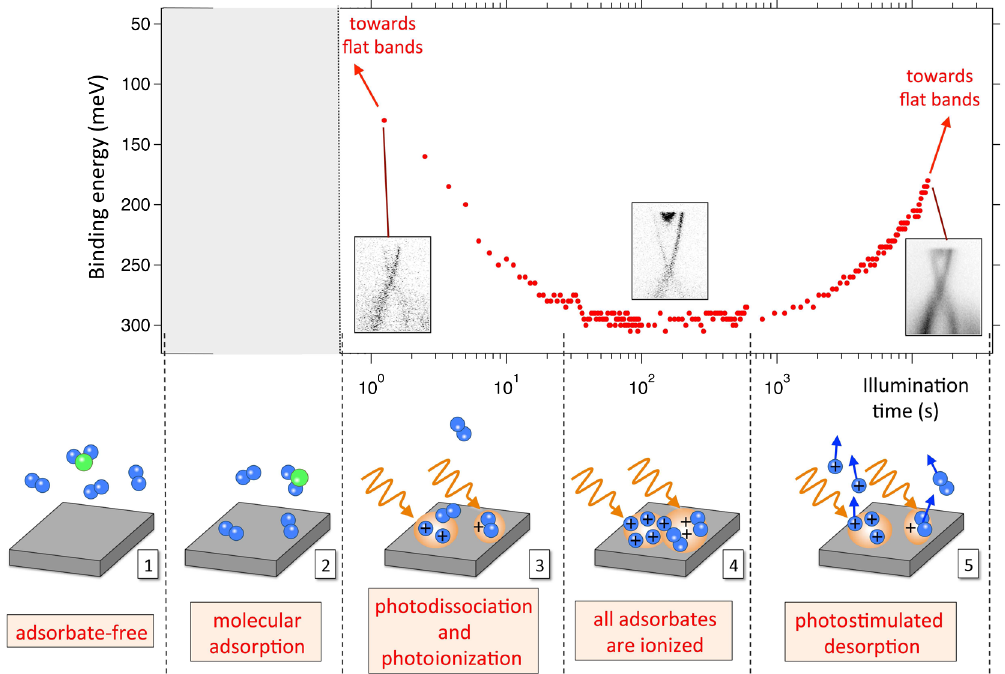
FIG. 5. The complete evolution of the band structure of TIs under intense illumination and a schematic of the underlying mechanism. Top: Evolution of E D at different time scales obtained on a single surface location of BiSbTeSe 2 during a standard ARPES experiment. From left to right: Intense illumination promotes downward band bending until a saturation point and from then on further exposure tends to flatten the bands again. Red arrows indicate that true flat-band conditions in an ARPES experiment on these materials can only be achieved at very short or very long time scales. The insets in the upper panel show the corresponding I ð E; k Þ diagrams at different illumination times. Prior to illuminating the surface location that was finally studied with ARPES, the sample had been exposed to residual gas molecules for 3 h, represented by the gray shaded area in the upper panel. The base pressure before and during measurements was, respectively, 1 . 0 × 10 − 10 and 5 . 0 × 10 − 11 mbar. All data have been acquired at 16 K using a 27 eV photon flux of 3 . 2 × 10 21 photons = ð s m 2 Þ . Bottom: Schematics of the five steps underlying our observations. Vertical dashed lines denote the time period to which each step corresponds. Step 1: immediately after cleavage, the sample surface is free of adsorbates. Step 2: residual gas molecules adsorb on the sample surface during the period while the latter is held in the “ dark." Step 3: under the influence of the intense EUV photon beam required to do ARPES, adsorbed molecules start to dissociate into single adatoms in the illuminated sample location [38]. Step 4: all adsorbed molecules are dissociated and/or photoionized, and band bending reaches a maximum. Step 5: Photostimulated desorption of adatoms and surface photovoltage (not illustrated) come into play and the bands shift back up